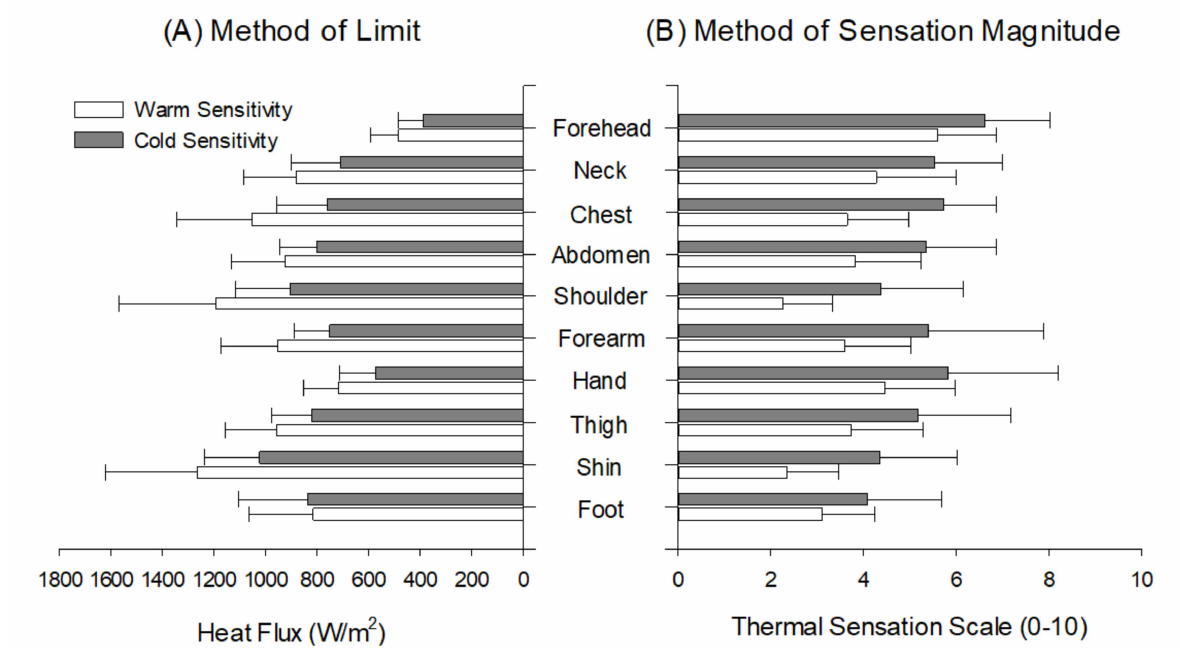
Figure 1. Comparison of warm and cold sensitivity of ten body regions between the method of limit and method of